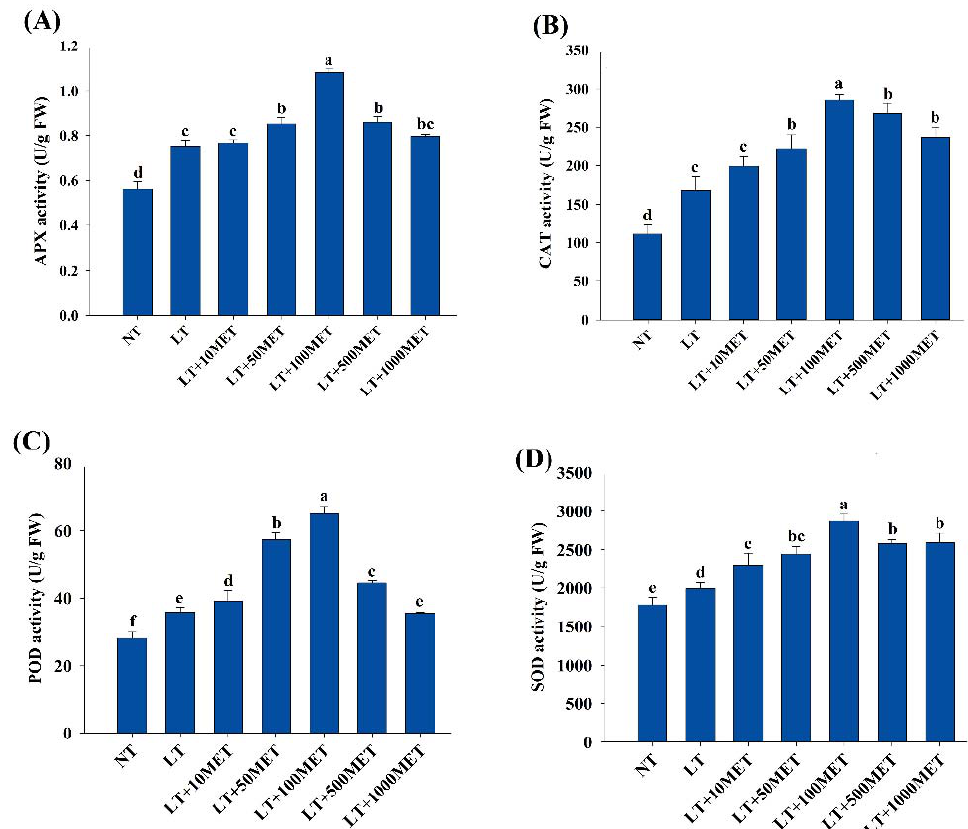
Figure 4. Effects of exogenous melatonin on the activities of antioxidant enzymes (APX ( A ) CAT ( B ), POD ( C ), and SOD ( D )) in strawberry seedlings under cold stress. Plants treated with distilled water under the normal conditions (25 ◦ C) served as control (NT). The strawberry seedlings were pretreated with distilled water (LT), 10 µ M melatonin (LT + 10MET), 50 µ M melatonin (LT + 50MET), 100 µ M melatonin (LT + 100MET), 500 µ M melatonin (LT + 500MET), and 1000 µ M melatonin (LT + 1000MET) for 3 times in a two-day interval and then exposed to cold stress for 2 days. Graphs represent the mean of three biological replicates. Values labeled with different letters indicate significant differences among treatments at ( p ≤ 0.05) by LSD.